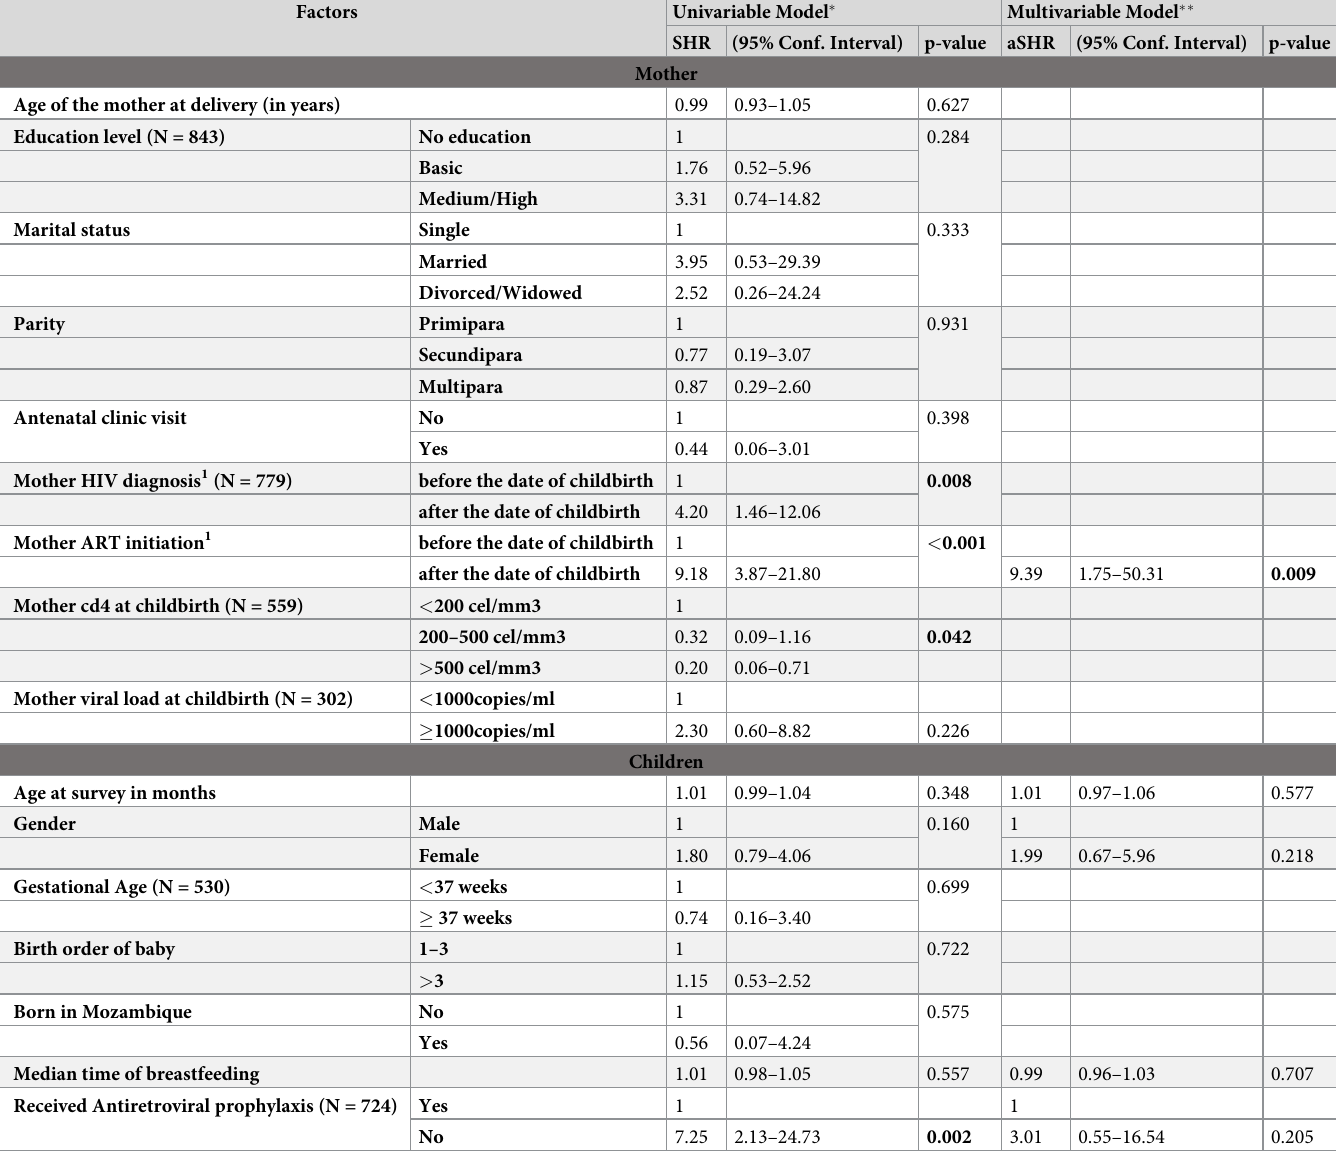
Table 3. Mother and child clinical and sociodemographic risk factors associated with postpartum MTCT among HIV-exposed children. N = 856. Fine-Gray subdis- tribution hazard regression with death as a competing risk was conducted. The same exclusion factors as those described in Table 2 were applied. The multivariable model was built of including the variables with a p-value lower than 0.20 in the bivariate analysis and with less than 20% missing values. Variables age of child, mother ART initia- tion and breastfeeding duration were forced-in covariates due to their clinical relevance. Multiple imputation was performed in mother ART initiation. Mother HIV diag- nosis was excluded because of